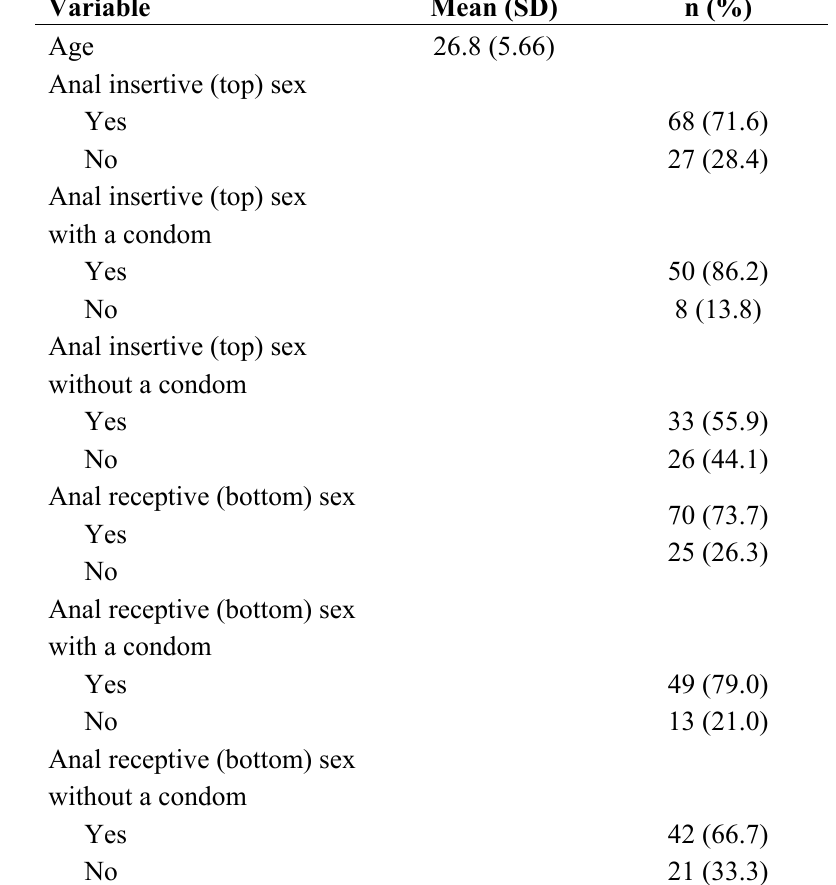
Table 1. Characteristics of the Study Sample, African American Men, Aged 18–39 ( N =